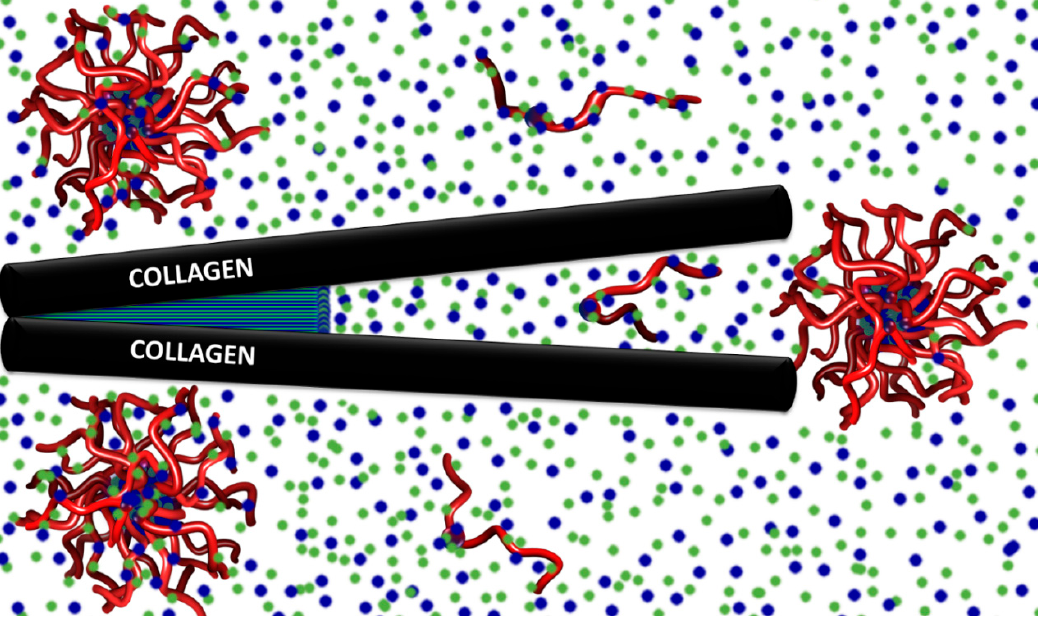
Figure 13. Schematic illustration of intrafibrillar mineralization due to steric exclusion of stabilizing polymers or phosphoproteins. According to this proposal, nucleation of CaP begins in the smallest intrafibrillar spaces because polymers that can inhibit nucleation and growth, or phosphoproteins that can inhibit or even reverse, nucleation and growth, are sterically excluded from those spaces. Nucleation and growth of ACP is inhibited in the larger pores and extrafibrillar spaces accessible to the polymer or phosphopeptide. Once intrafibrillar HA crystals are formed, their growth can continue by the solution-mediated transfer of ions from the metastable or stable complexes of CaP with polymers or phosphoproteins, respectively.